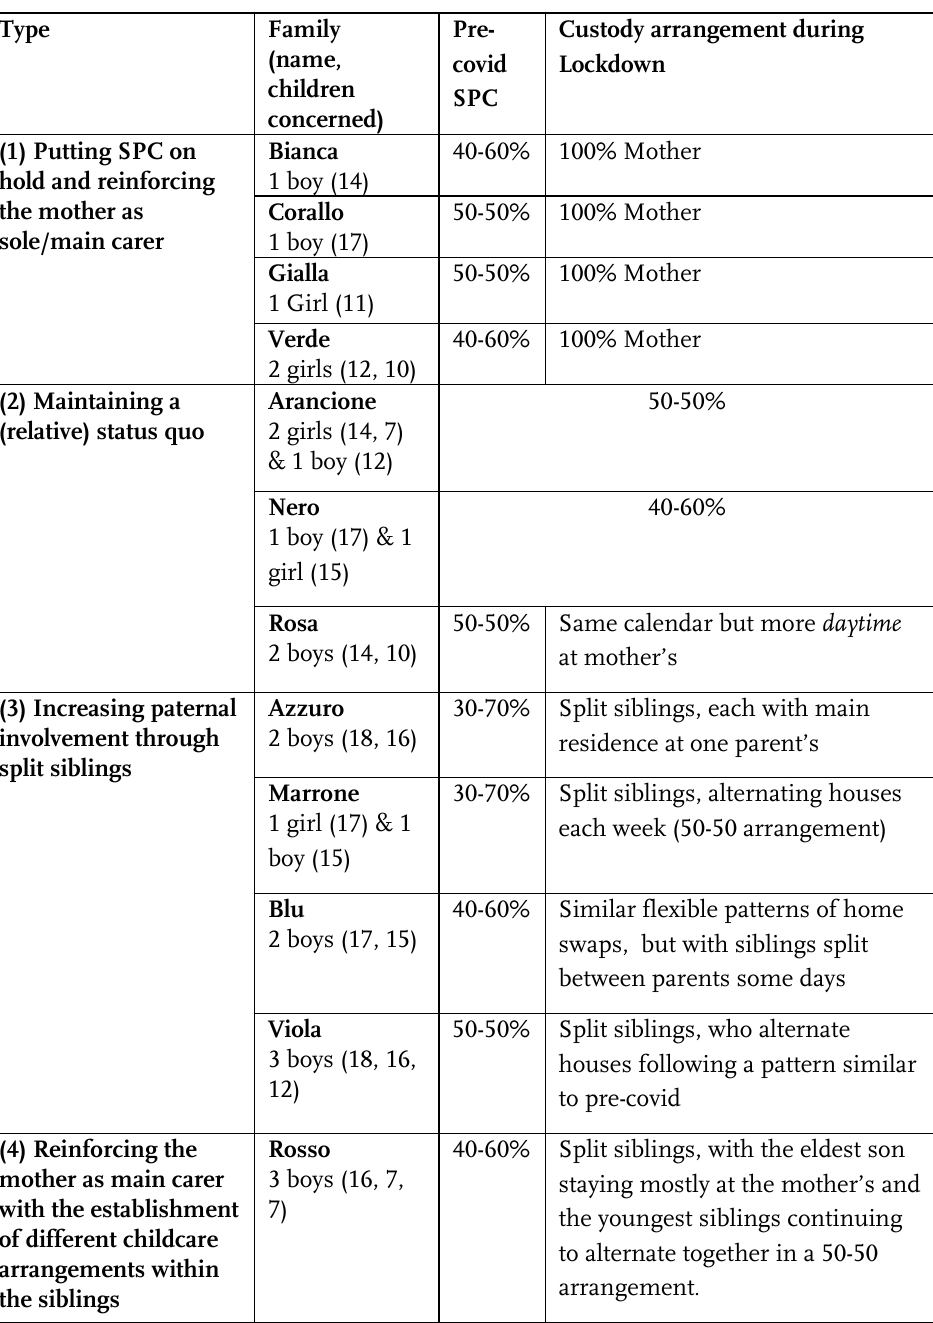
Table 2: Typology of custody re-organizations under Lockdown